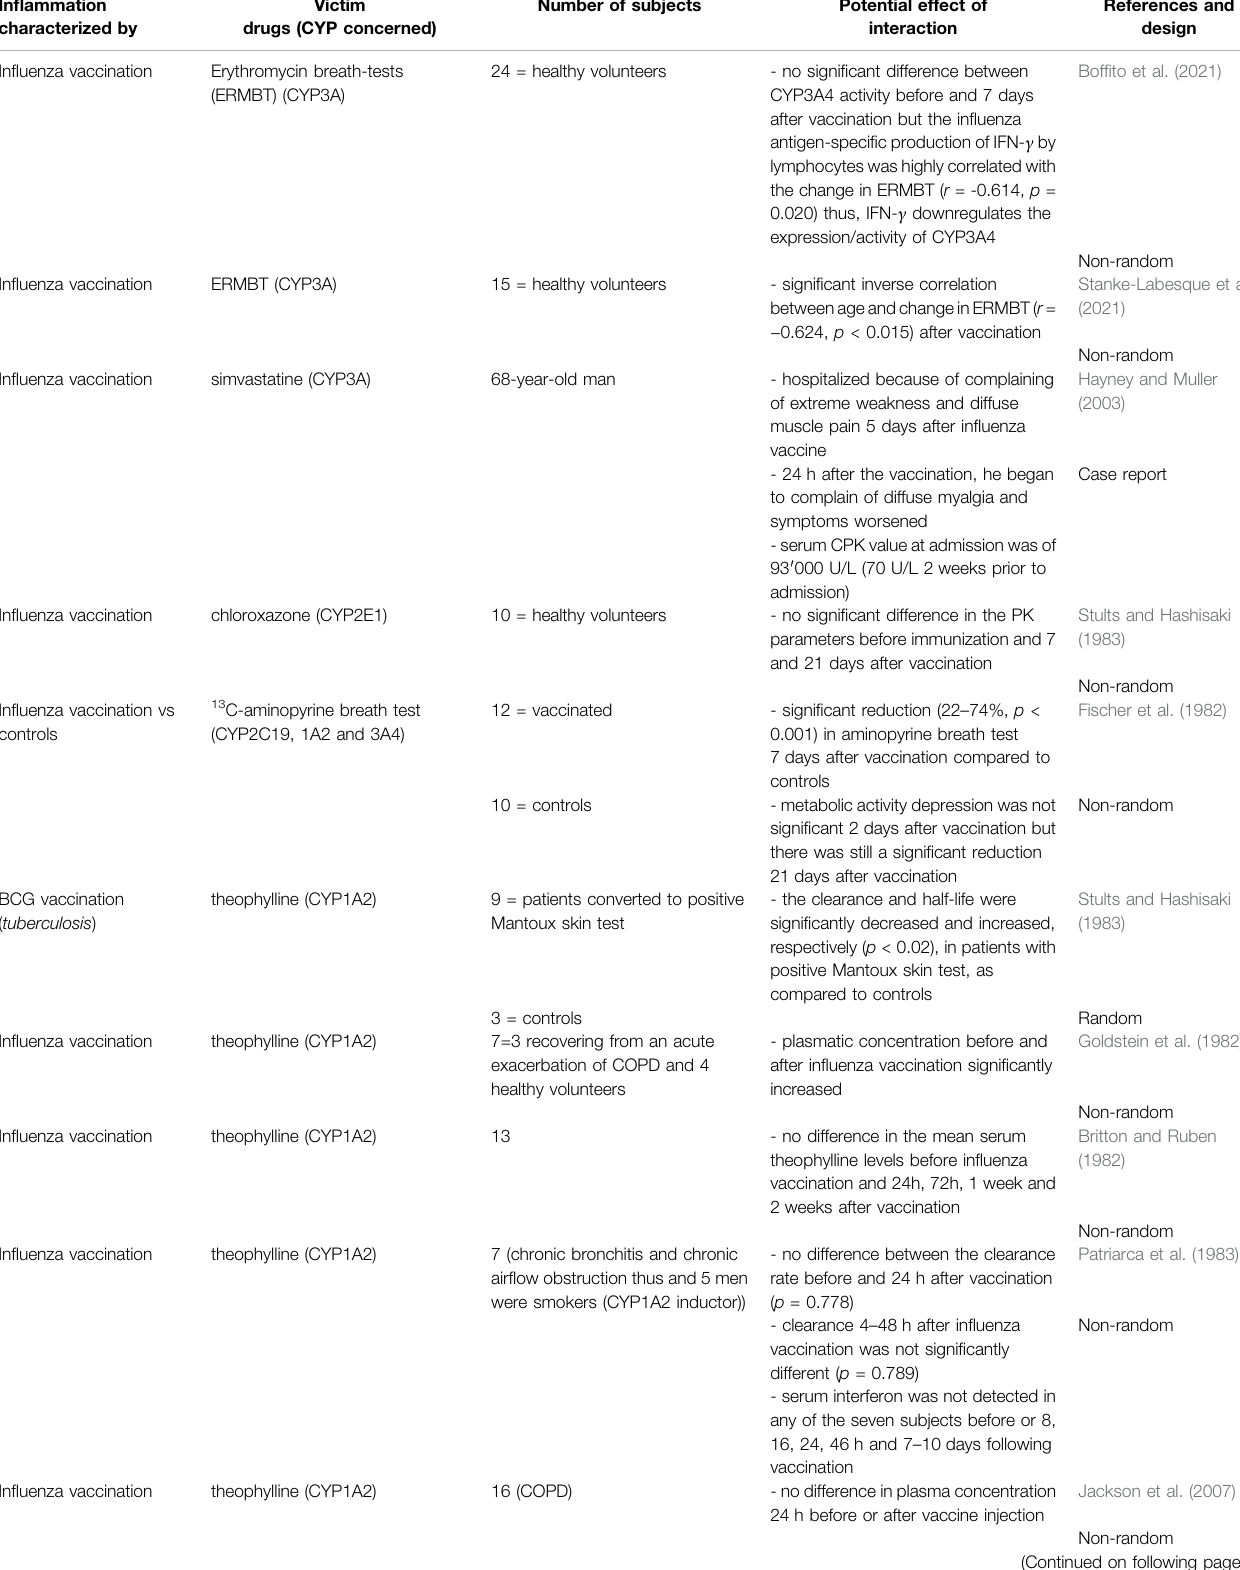
TABLE 3 | Impact of vaccination on CYP substrates, explained totally or partially by modulation of CYP activity. In fl ammation characterized